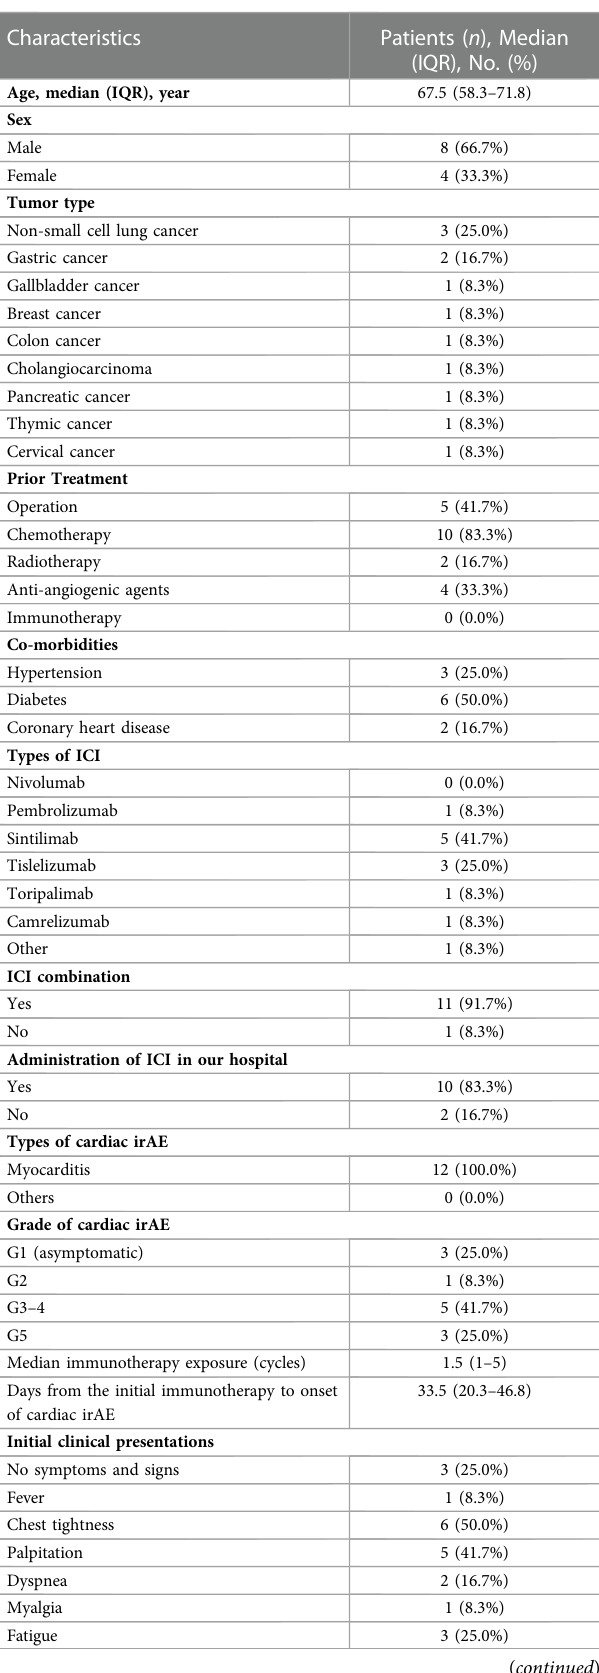
TABLE 2 Basic line clinical characteristics of patients with ICI-related cardiac